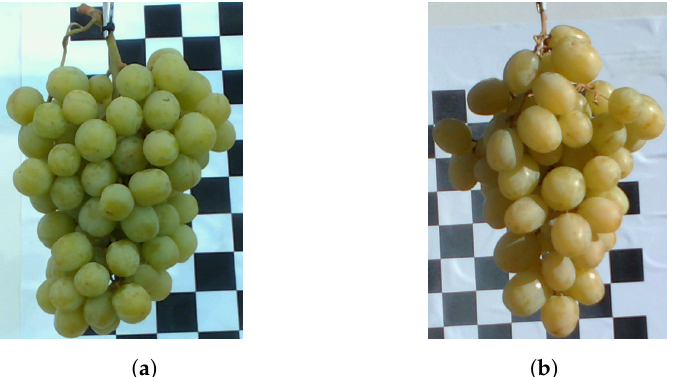
Figure 3. Coloured images of the grape bunches used in this work for scans captured ( a ) indoors and ( b ) outdoors.